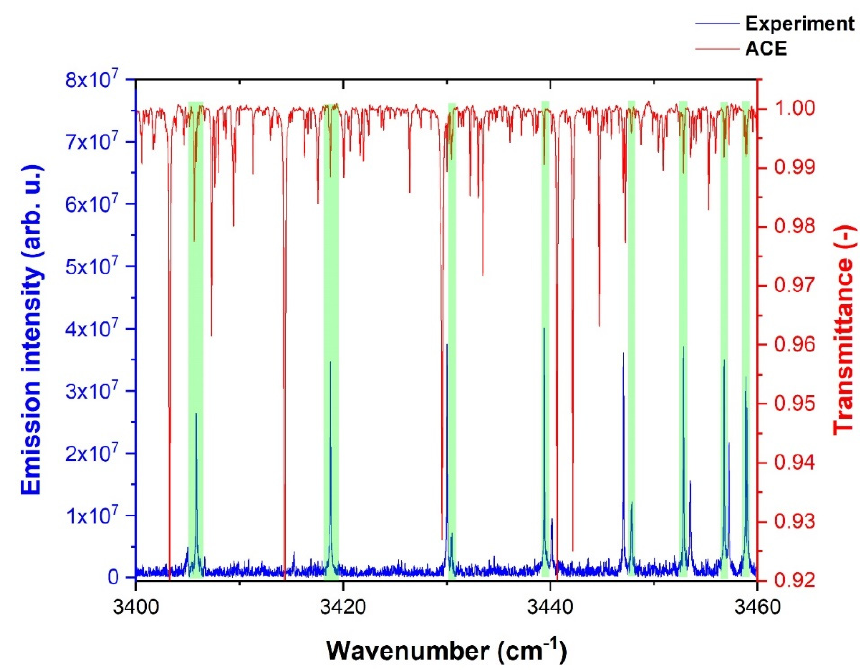
Figure 17. Comparison of ACE solar spectrum and our NH radical data [153].